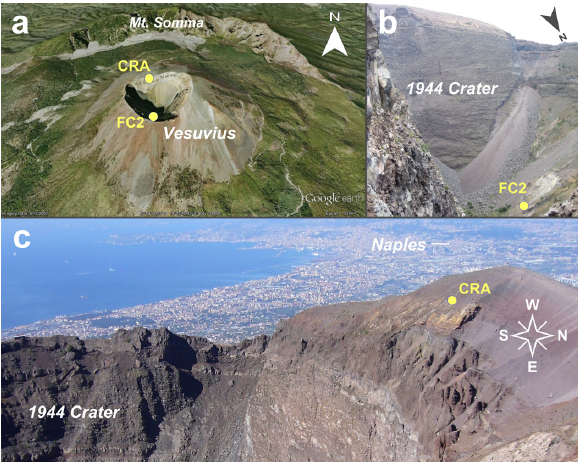
Figure 2. From top to bottom, clockwise: a) aerial view of the Mt. Somma-Vesuvius complex (source of image: Google Earth) with the locations of fumarole temperature monitoring stations; b) pic- ture taken from the north-western rim of the 1944 crater illustrat- ing the position of FC2 station; c) picture taken from the top of Mt. Vesuvius illustrating the position of CRA